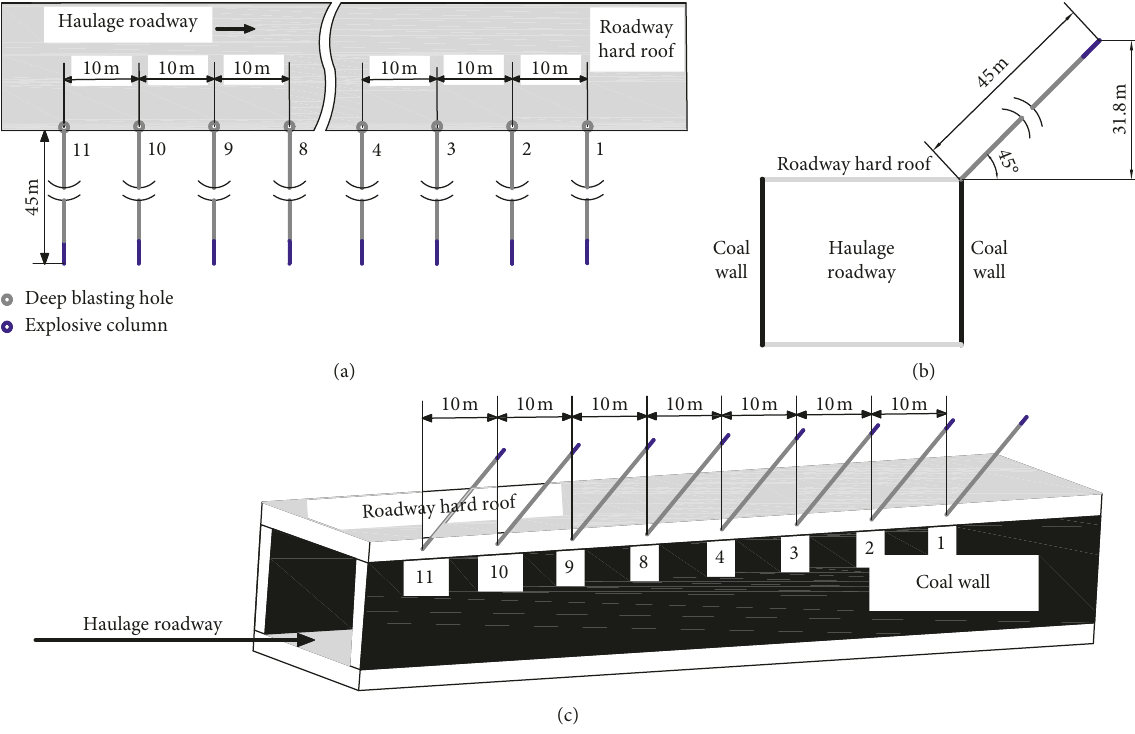
Figure 6: “Straight-line” blasting layout. (a) Top view of blasting layout. (b) Cross-sectional view of blasting layout. (c) 3D drilling position.